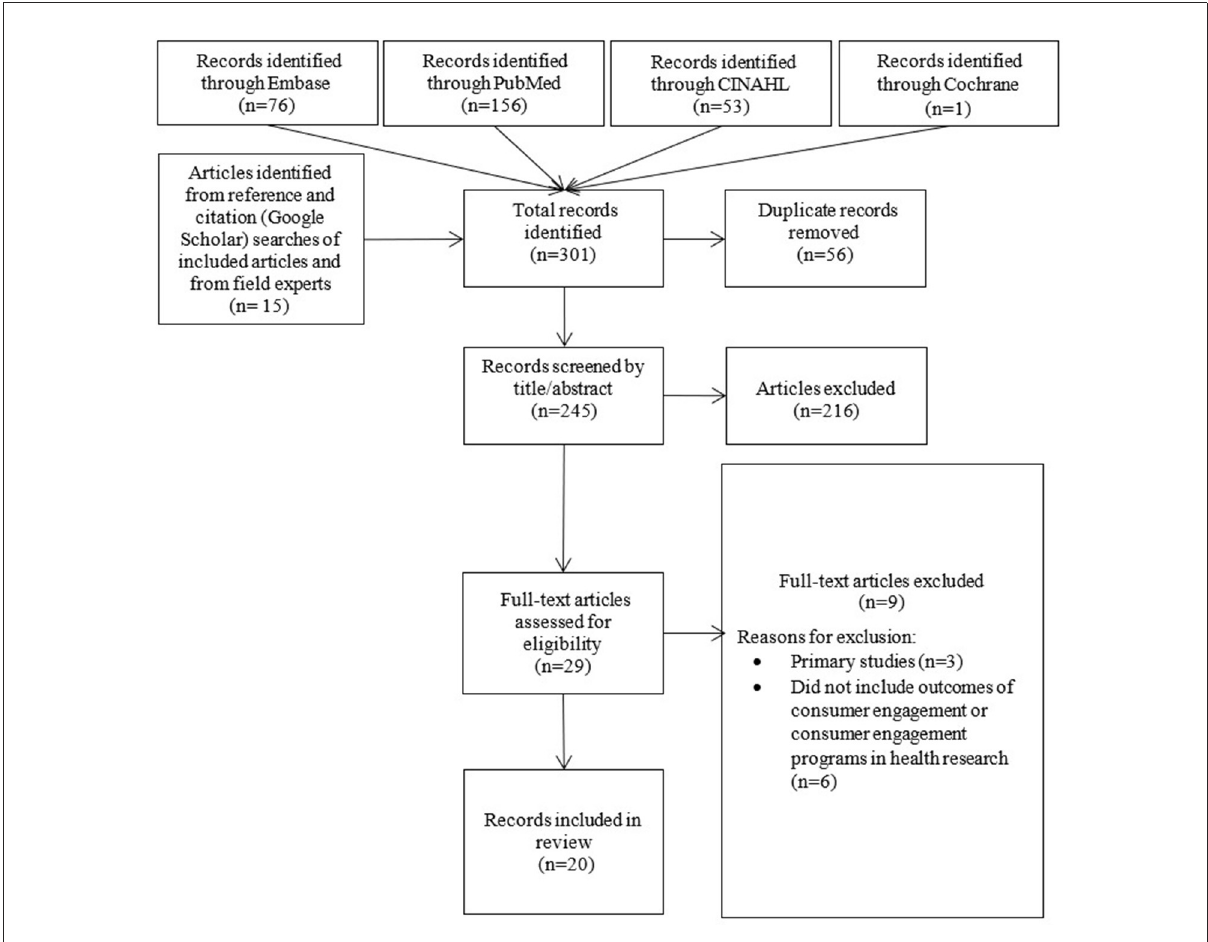
FIGURE1 PRISMA flowchart of database and citation